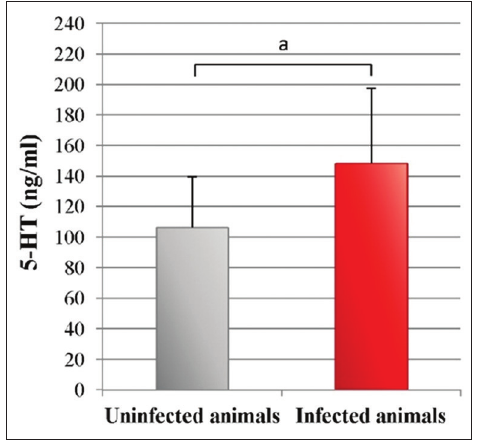
Figure-1: Plasma concentrations of serotonin or 5-hydroxytryptamine (mean±standard deviation) in sheep. Letter indicates significant differences between uninfected and infected animals: a